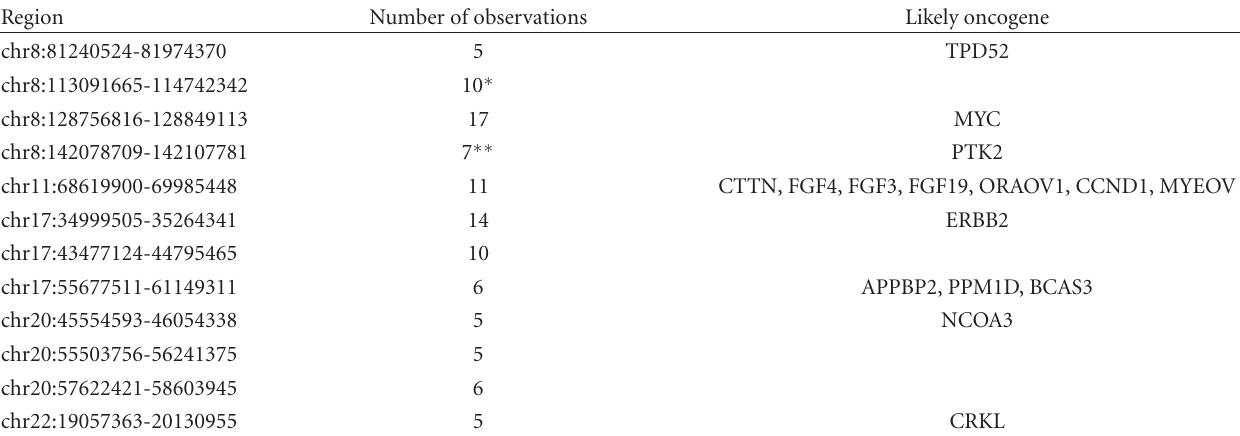
Table 4: Frequent amplifications with CN > 9 observed in 178 cancer cell lines. Chromosomal positions are based on March 2006 version of the UCSC Human Genome Browser. Region Number of observations Likely